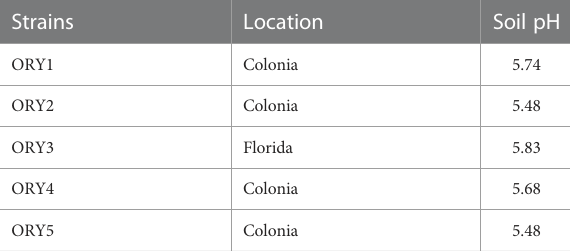
TABLE 1 Location and pH of soils from where M. sativa inef fi cient rhizobia strains were isolated.